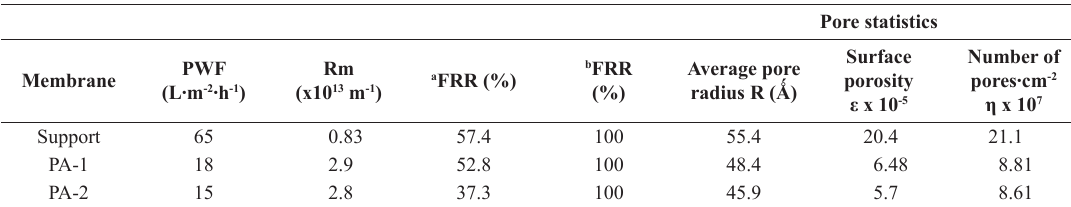
Figure 3. Pore size distribution by mercury porosimetry intrusion analysis: (a) ceramic support , (b) PA-1 and (c) Table 1. Values of some characterization parameters of membranes.